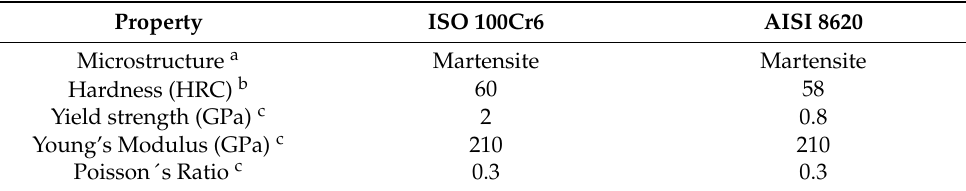
Table 2. Mechanical properties of bearing